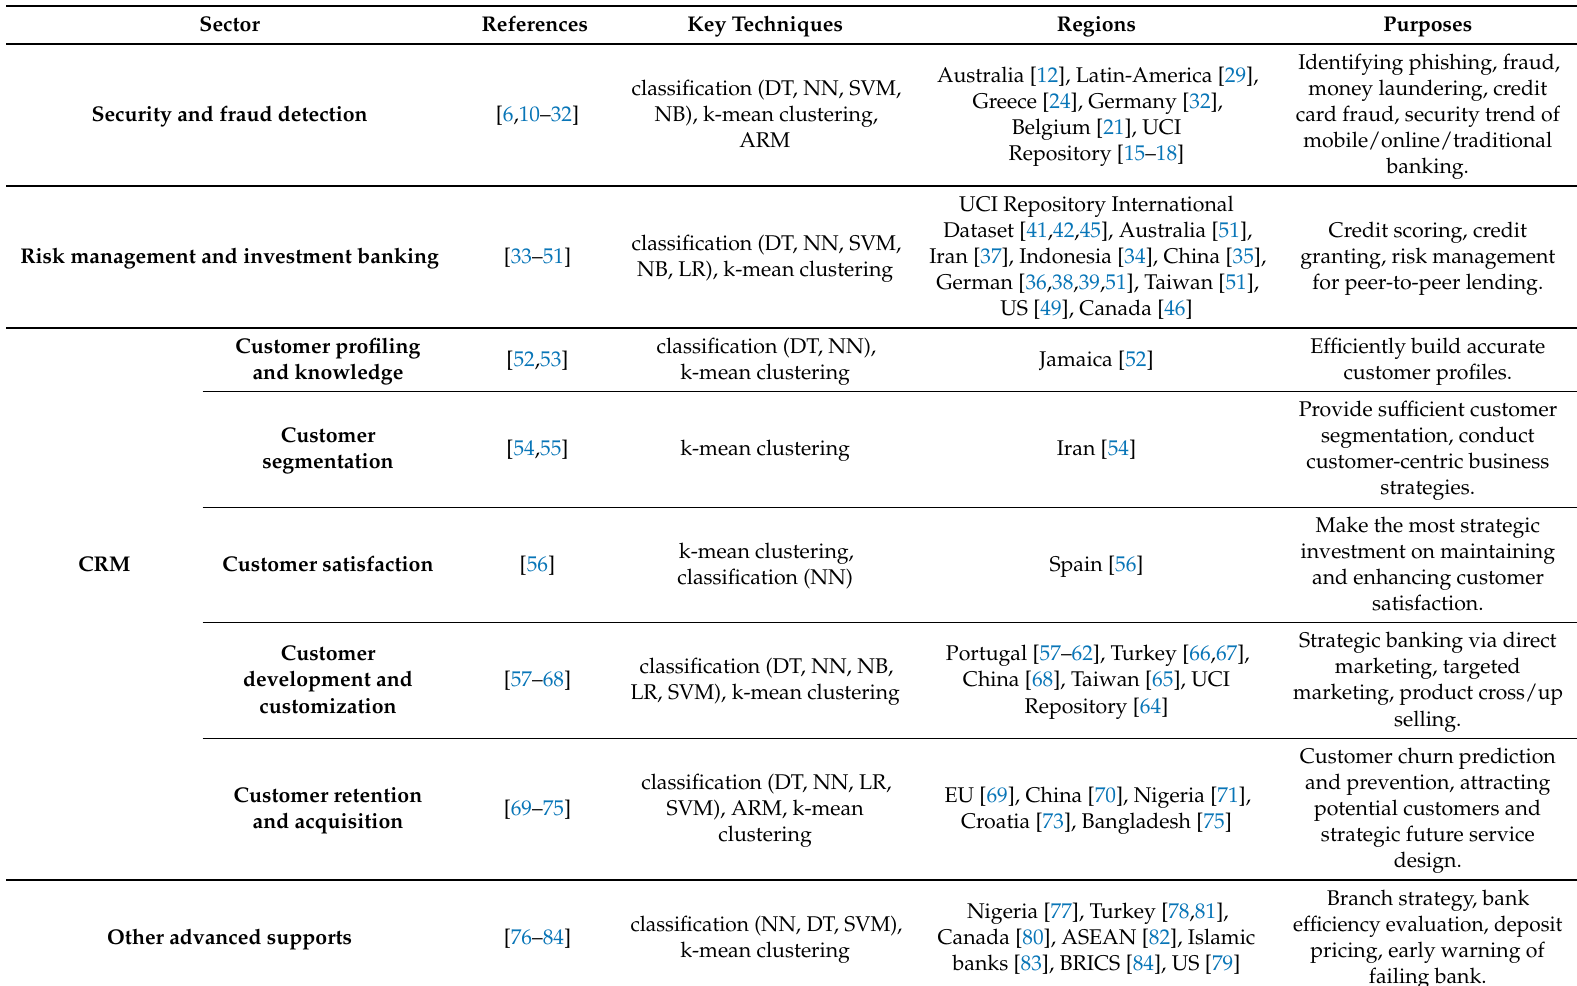
Table 1. Summary table of Data Mining applications in banking since